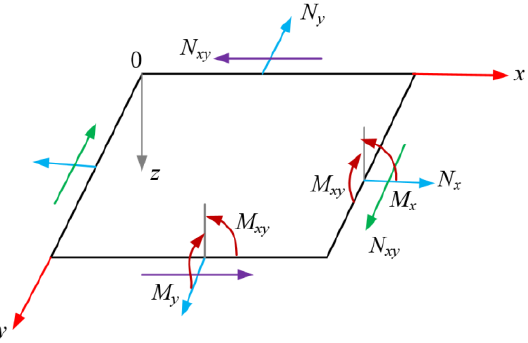
Figure 2. Schematic diagram of the action of plane internal forces and bending moments of the laminate.